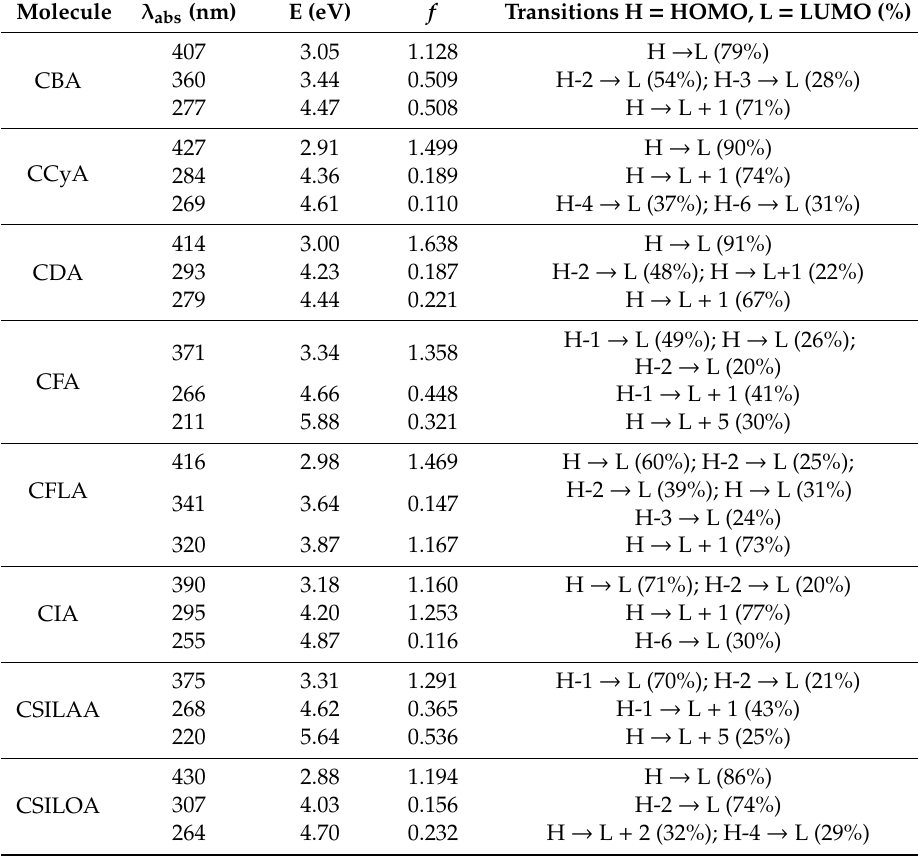
Figure 4. Ultraviolet Visible (UV-Vis) absorption spectra of carbazole-based dyes with the M06-2X/6-31G(d) level of theory. Table 2. Absorption wavelengths, vertical excitation energy (E), oscillator strengths ( f ), and the orbitals involved in the transitions of carbazole-based dyes with the functional M06-2X and the basis set 6-31G(d), using chloroform as solvent.